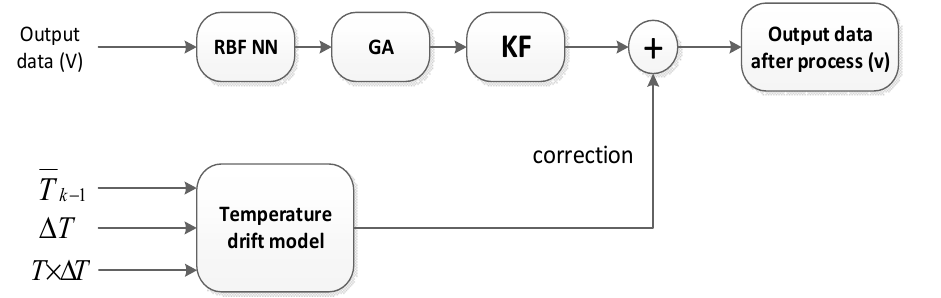
Figure 8. The process of RBF NN + GA + KF fusion algorithm.